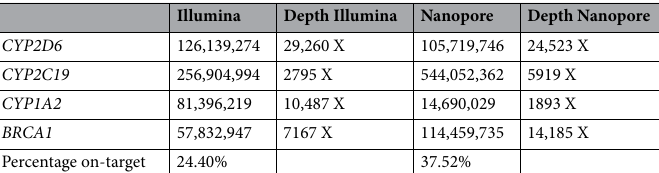
Table 2. Number and percentage of nucleotides on-target and average